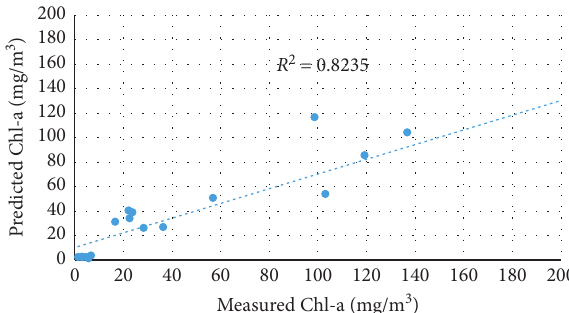
Figure 13: Regression between predicted and measured Chl-a using the Ln(B2/B3) model.